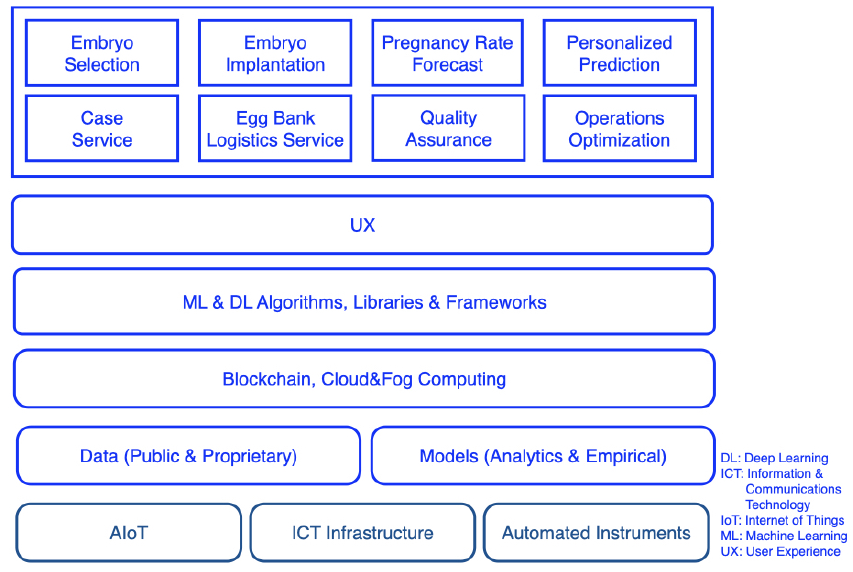
Figure 8. BABIES Software